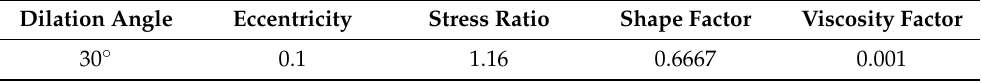
Table 3. Plasticity parameters for